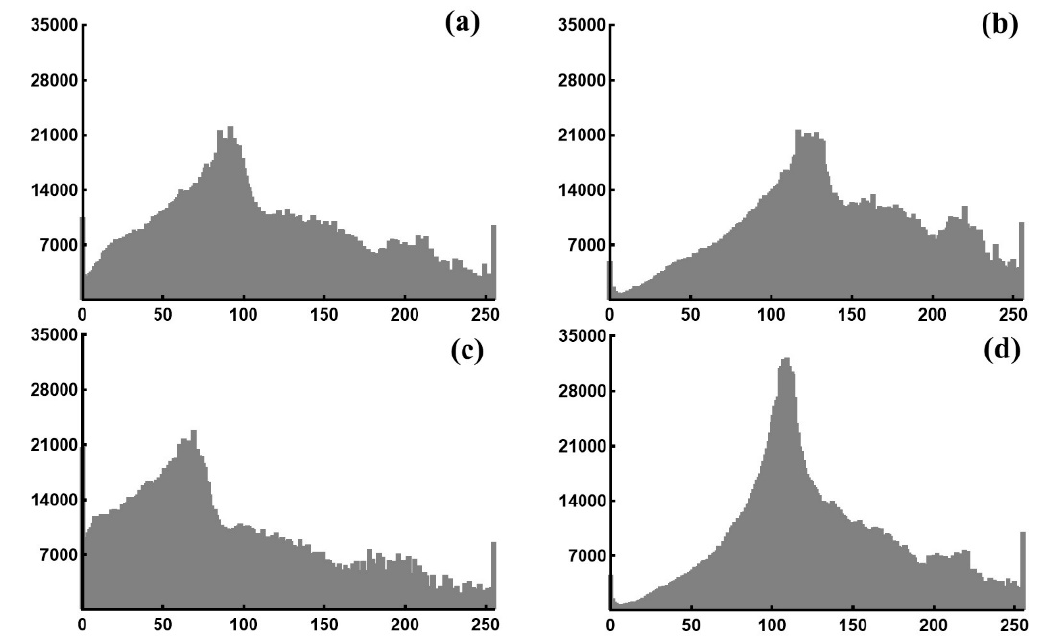
Figure 4. Gray histogram: ( a ) Initial image, ( b ) γ = 0.7, ( c ) γ = 1.3, and ( d ) our method.